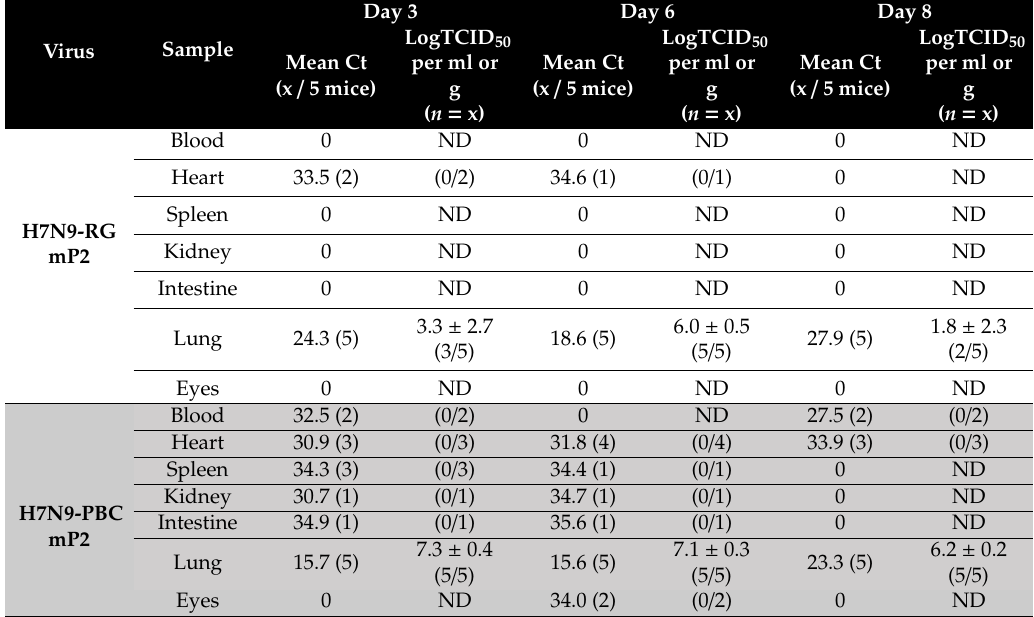
Table 2. Replication of H7N9-RG and H7N9-PBC mouse-passaged viruses in mice. Groups of mice ( n = 5) were infected intranasally with 10 2 PFU of either H7N9-RG mP2 or H7N9-PBC mP2 viruses, blood and tissues were collected on days 3, 6, and 8 post-infection. Viral load was first measured by RT-qPCR detecting the M gene, with mean Ct values reported, and the limit of detection of the assay was 50 genome copies / mL or / g tissue. For all RT-qPCR positive samples, infectious viral loads were determined by TCID 50 assay, where x is the number of samples that were RT-qPCR positive, and the mean logTCID 50 / mL or / g ± standard error of mean is shown. ND = not determined. Day 3 Day